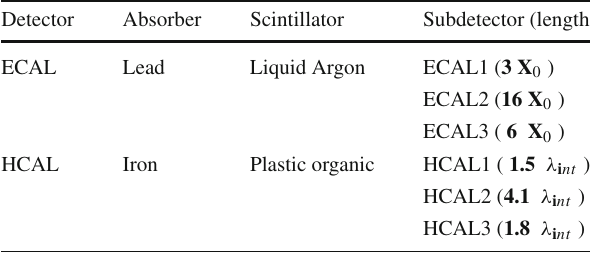
Table 1 Material budget of the ECAL and HCAL calorimeters as well asthecorrespondingequivalentradiation